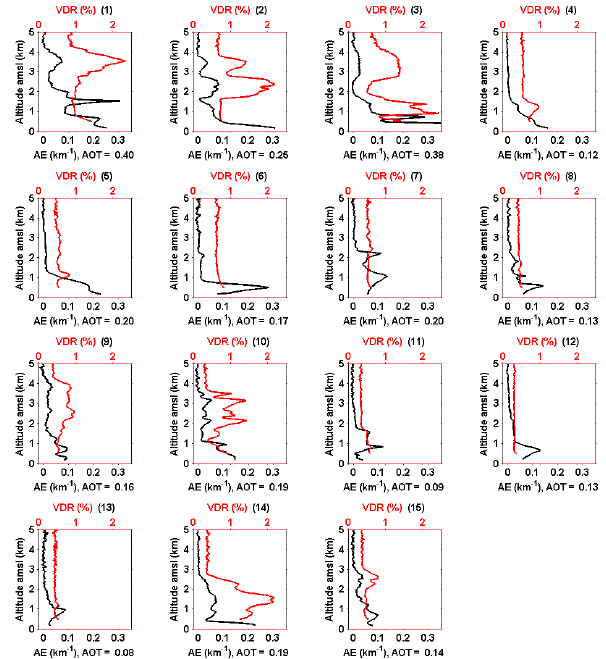
Figure 8. Aerosol extinction coefficient (AE in km − 1 , black lines) and volume depolarization ratio (VDR in %, red lines) as a function of altitude for the inter-comparisons cases during HyMeX experi- ment. For each individual case, the atmospheric optical thickness (AOT) is also reported. The CN is given in black at the top of each